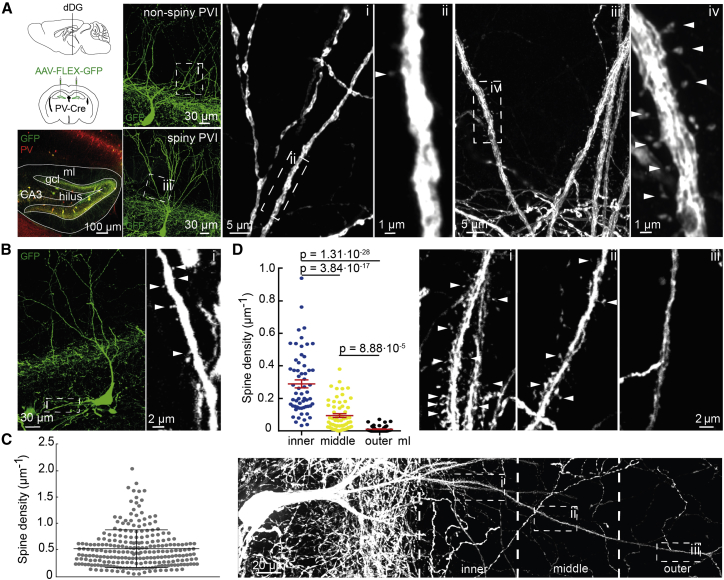
A Subpopulation of PVIs in the dDG Expresses Variable and Input-Specific Densities of Dendritic Spines(A) AAV-FLEX-GFP was injected into the dDG of PV-Cre mice. Co-localization of GFP (green) and PV (red) was confirmed by immunohistochemistry. Example images of transduced non-spiny (top) and spiny (bottom) apical dendrites of PVIs are shown alongside confocal gray-scale magnifications of boxed areas. Roman numbers link boxed areas to matching magnifications. Arrowheads indicate examples of spines.(B) Example of spines on basal PVI dendrites with a gray scale magnification of the boxed area.(C) Spine densities of individual apical dendritic segments show high variability (n = 248 segments, 37 neurons, 3 mice; bars are mean ± SD).(D) Apical spine densities decrease from inner to outer ml (n = 60 neurons, 6 mice; bars are mean ± SEM). Right, images i, ii, and iii show higher magnifications of a typical spiny PVI dendrite crossing the ml sublayers (bottom).